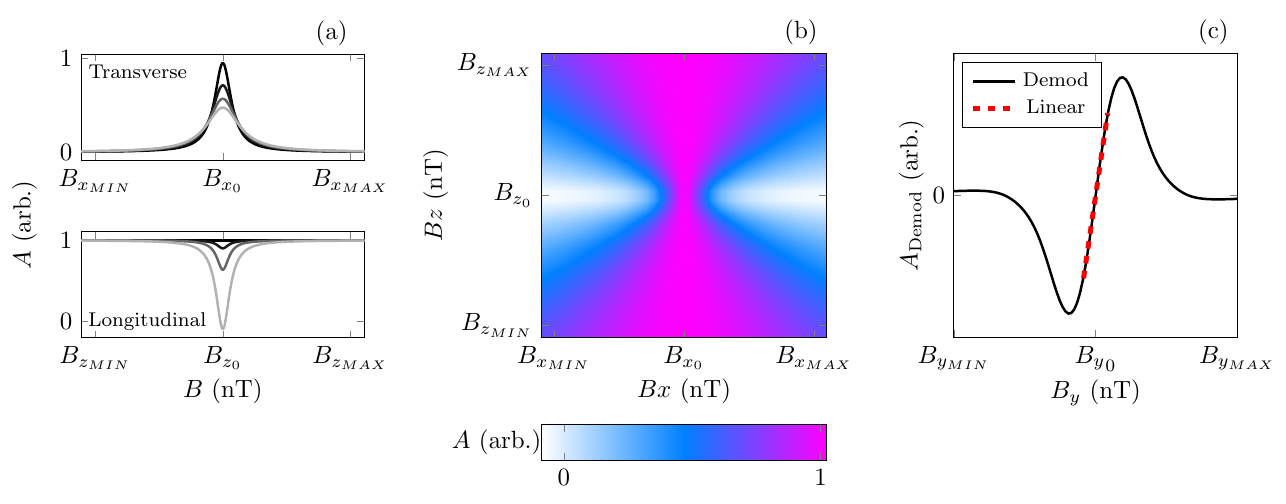
(darkest line). 0 or B y (darkest 0 0 to B y . The resultant photodiode signal is MIN MAX